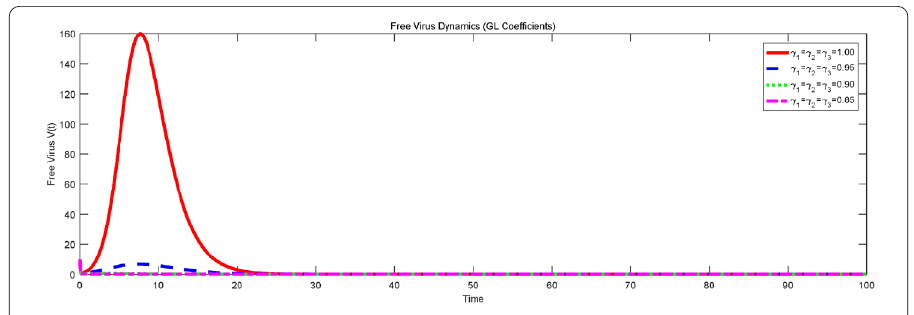
Figure 10 Dynamics of V ( t ) with γ i = 1 (solid red line), γ i = 0.95 (dashed blue line), γ i = 0.9 (dotted green line) and γ i = 0.85 (dotted dashed magenta line), i = 1,2,3.